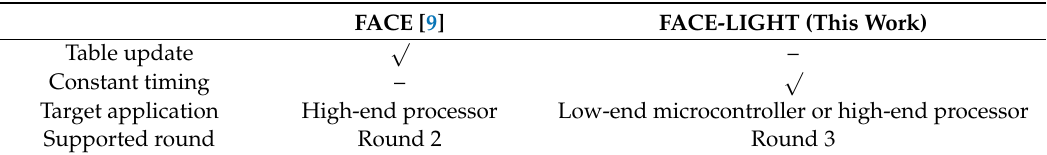
Table 2. Comparison of functionality between FACE and FACE–LIGHT.